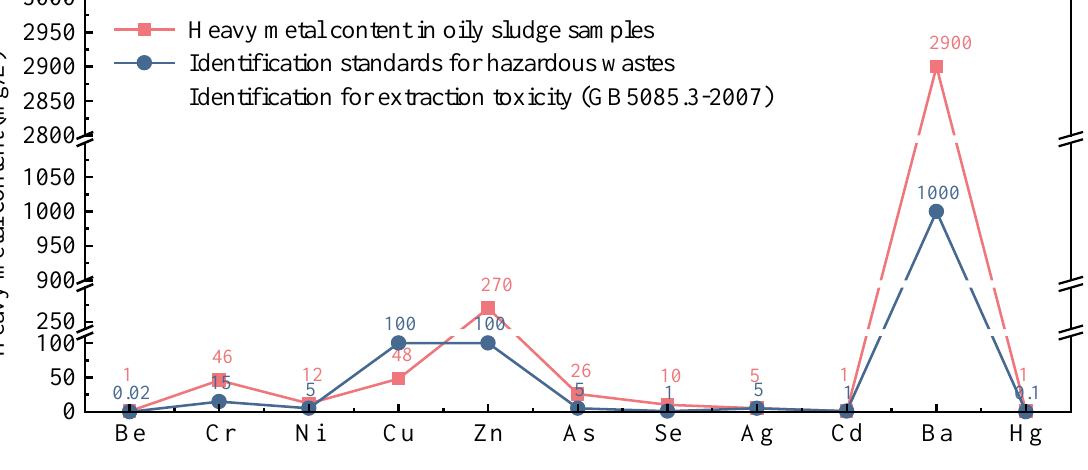
Figure 6. Heavy metal content of oily sludge.